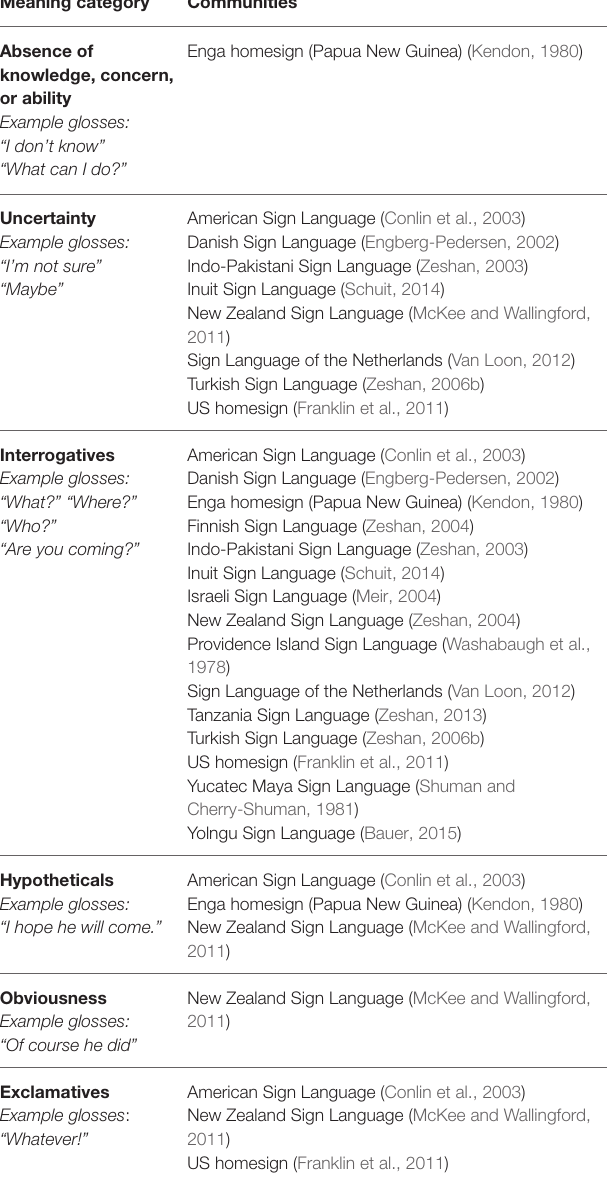
TABLE 2 | Observed uses of the palm-up epistemic in